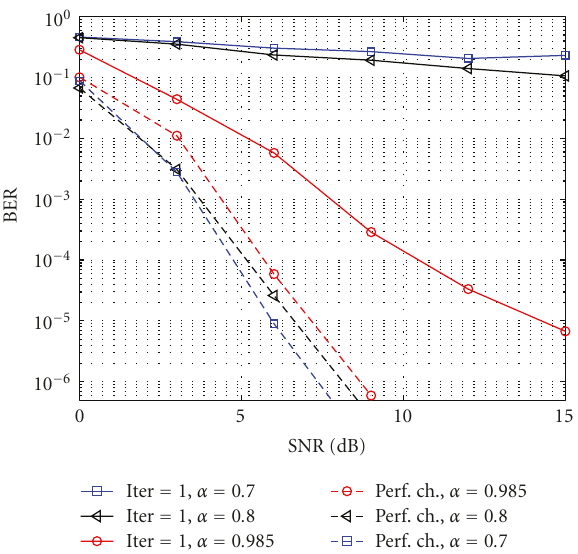
Figure 6: BER performance with varying time correlation with six pilots.